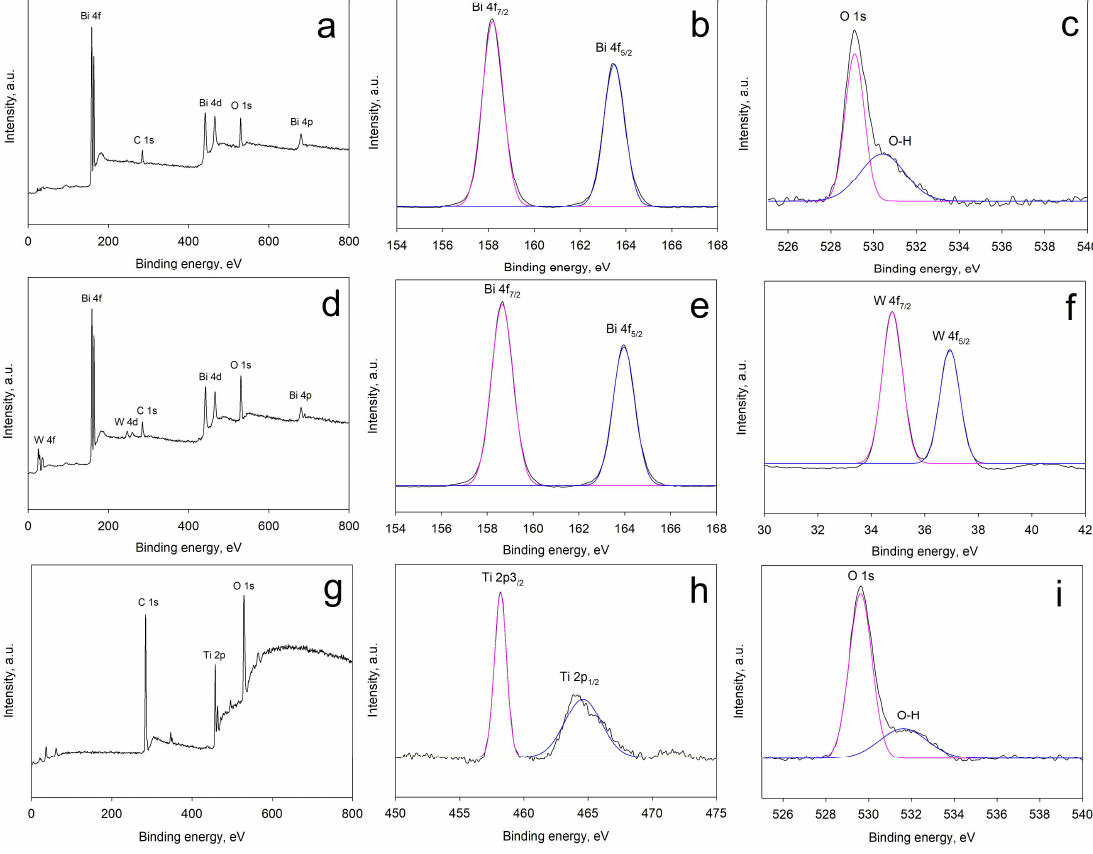
Figure 4. XPS results of 2-mm coated beads: sample Bi0 ( a ) survey spectrum, ( b ) Bi 4f spectrum, ( c ) O 1s spectrum; sample BiW1 ( d ) survey spectrum; ( e ) Bi 4f spectrum; ( f ) W 4f spectrum; sample TiO 2 ; ( g ) survey spectrum; ( h ) Ti 2p spectrum; and ( i ) O 1s spectrum.